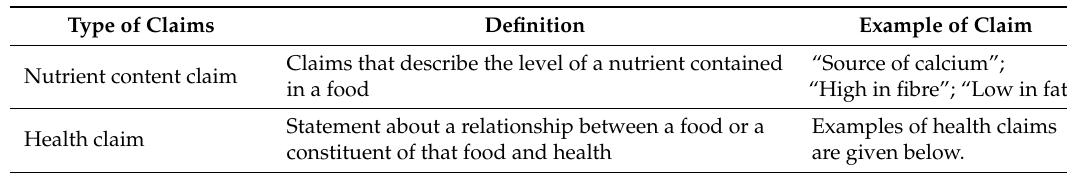
Table 1. Types of